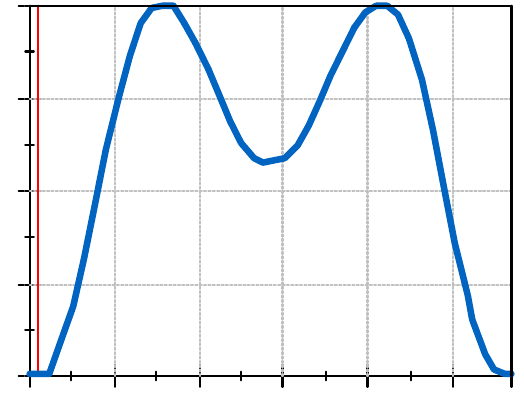
Figure 12: The force acting on the foot during the stance phase.